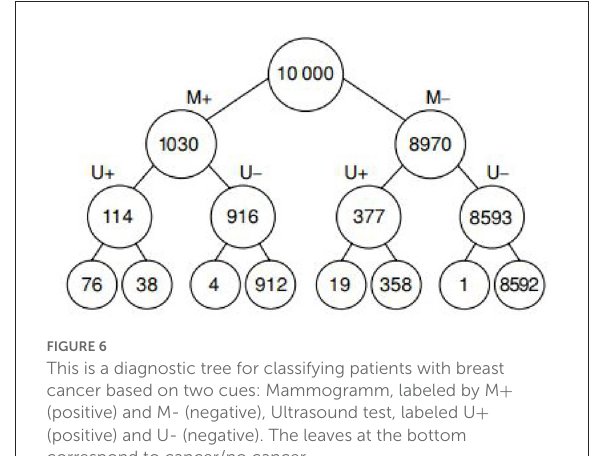
FIGURE6 This is a diagnostic tree for classifying patients with breast cancer based on two cues: Mammogramm, labeled by M + (positive) and M- (negative), Ultrasound test, labeled U + (positive) and U- (negative). The leaves at the bottom correspond to cancer/no